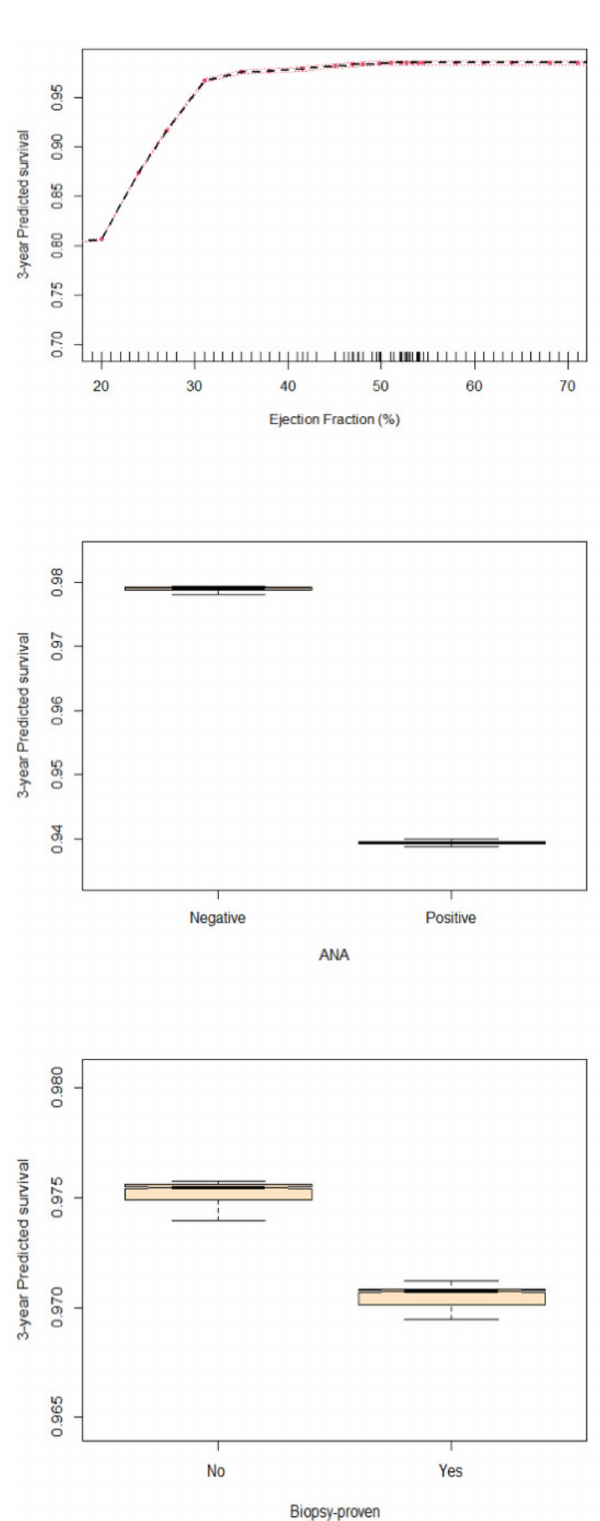
Figure 3. Plot of the marginal effect of left ventricular ejection fraction (LVEF), anti-nuclear auto- antibodies (ANA) and biopsy proven status on 3-year predicted survival